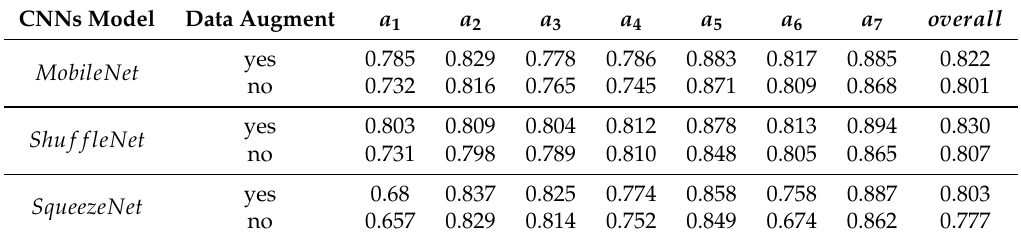
Table 3. Recognition accuracy for seven